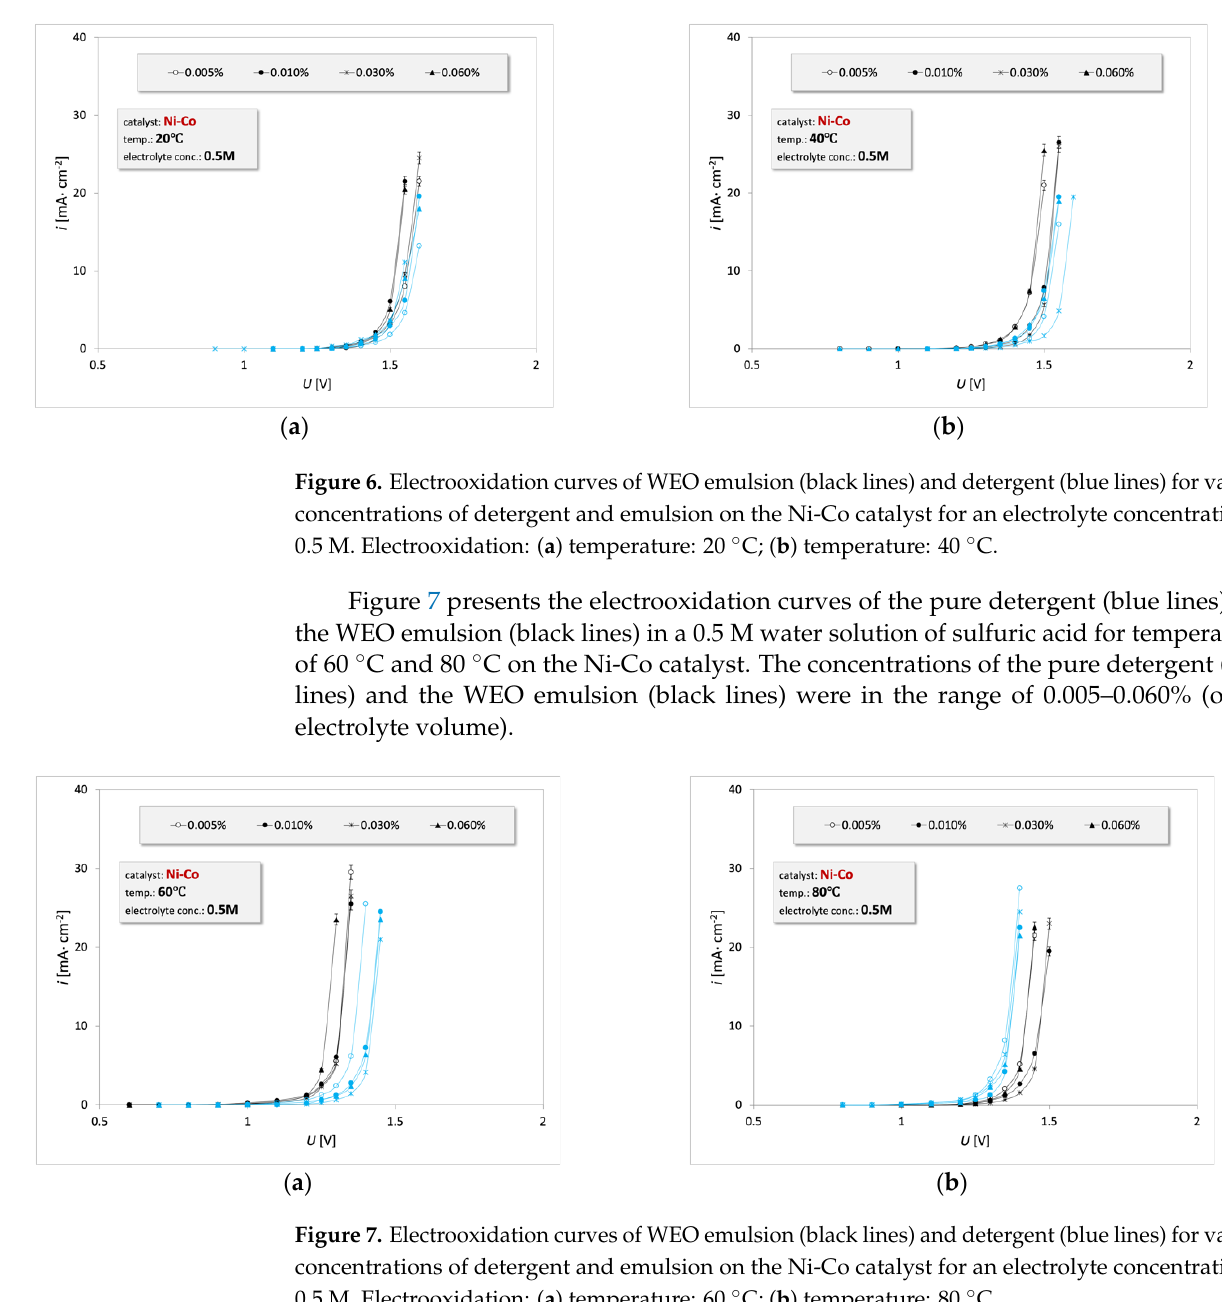
( b ) Figure 8. Electrooxidation curves of WEO emulsion (black lines) and detergent (blue lines) for var- ious concentrations of detergent and emulsion on the Ni-Co catalyst for an electrolyte concentration of 2 M. Electrooxidation: ( a ) temperature: 20 °C; ( b ) temperature: 40 °C. Figure 9 presents the electrooxidation curves of the pure detergent (blue lines) and the WEO emulsion (black lines) in a 2 M water solution of sulfuric acid for temperatures of 60 °C and 80 °C on the Ni-Co catalyst. The concentrations of the pure detergent (blue lines) and the WEO emulsion (black lines) were in the range of 0.005 – 0.060% (of the elec- trolyte volume).